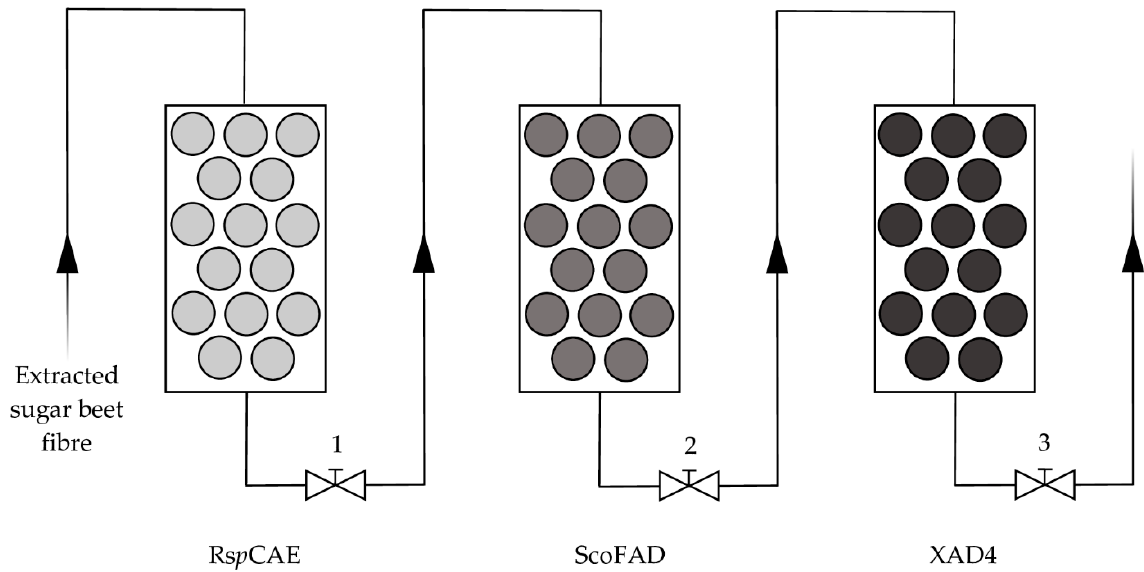
Figure 6. Scheme of the experimental setup. Both immobilized enzymes and the activated adsorbent XAD4 were filled into spin columns and connected under exclusion of air using generic tubing. Three valves were applied to enable sample collection after each process step ( ).